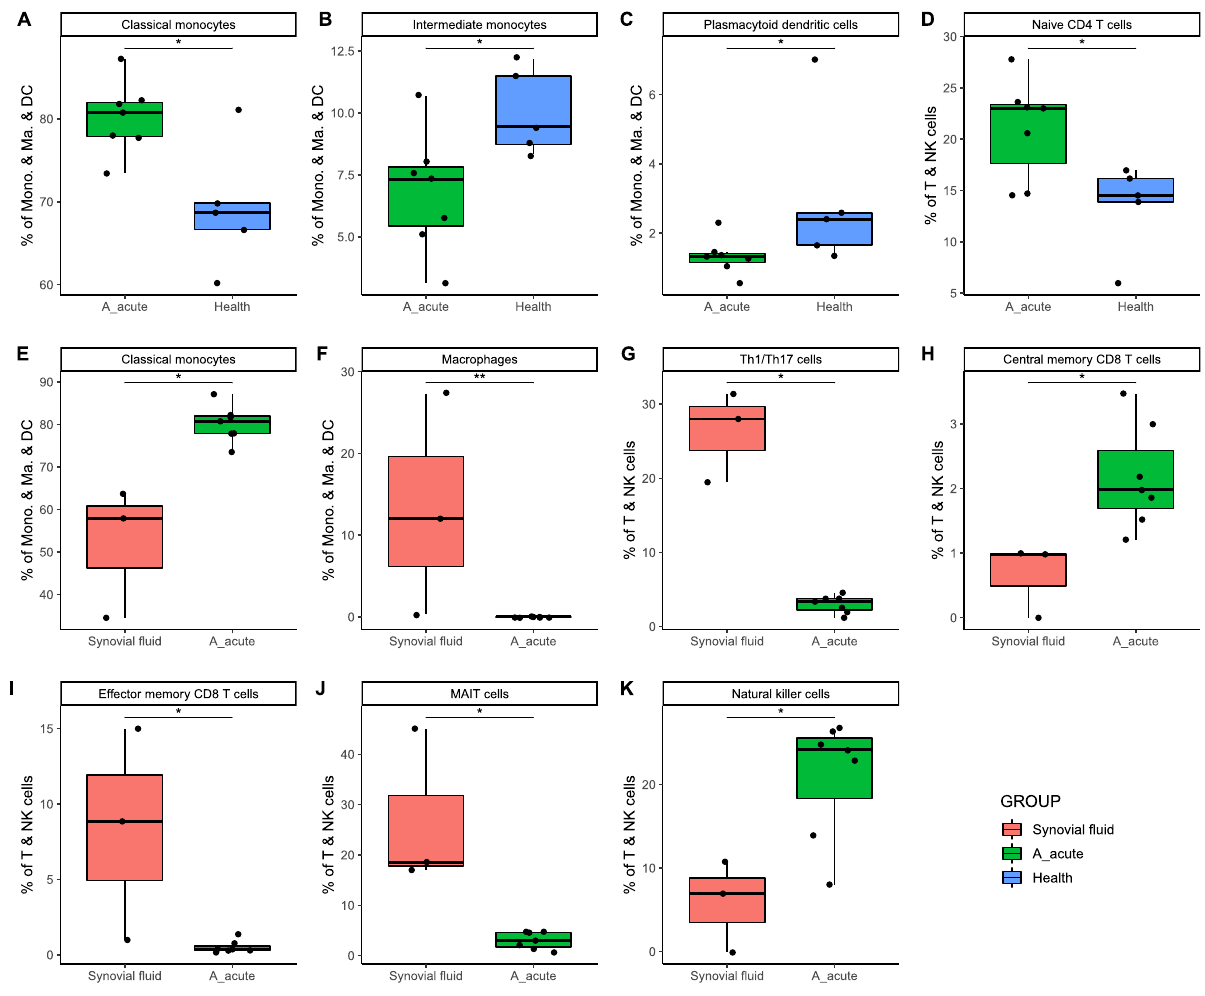
Figure 2. Relative abundance of cell subpopulations between PBMCs from acute gout patients and either PBMCs from healthy subjects or SF. ( A – D ) Relative abundance of cell subpopulations in PBMCs from acute gout and healthy subjects. ( E – K ) Relative abundance of cell subpopulations compared between PBMCs from patients with acute gout and SF samples. The cell subpopulations examined in this comparison were ( A – F ) monocyte series and ( G – K ) T and natural killer (NK) cells. * P < 0.05; ** P <